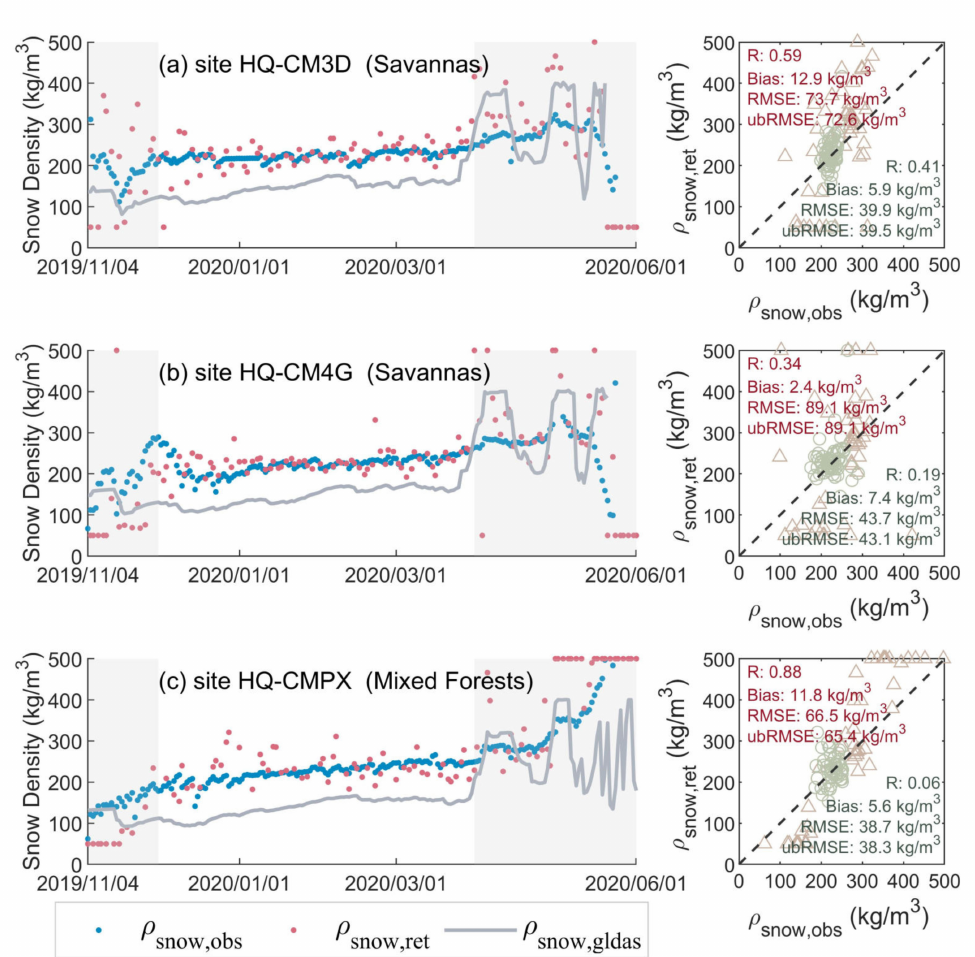
Figure 10. Time series and scatterplots of in-situ and retrieved snow density using manually adjusted predetermined parameters ( τ , ω , S D ) at the three stations: ( a ) HQ-CM3D, ( b ) HQ-CM4G, ( c )